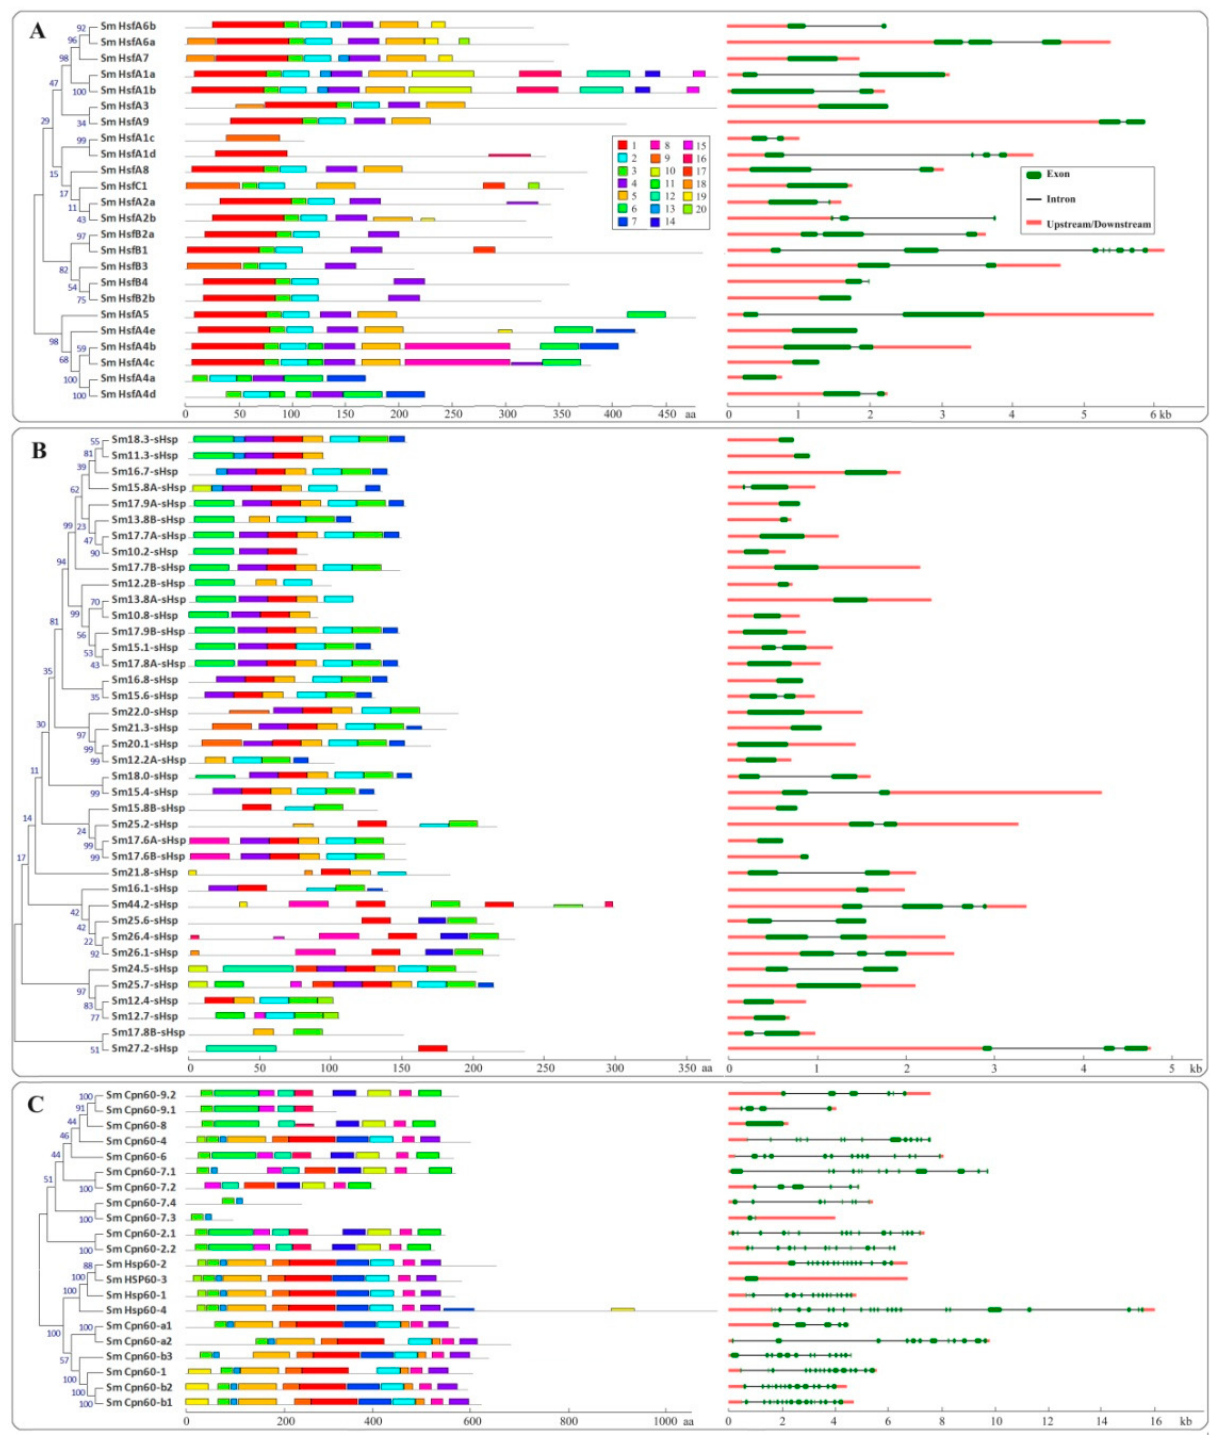
Figure 1. Phylogenetic relationships, gene structures and motif compositions of Hsf, sHsp and Hsp60 family members in eggplant. Multiple alignment of the Hsf ( A ), sHsp ( B ) and Hsp60 ( C ) proteins from eggplant (Sm) was performed with MEGA 5.0 using the neighbor-joining (NJ) method with 1000 bootstrap replicates (left panel). A schematic representation of conserved motifs (obtained using MEME) in the Hsf and sHsp proteins is displayed in the middle panel. Different motifs are represented by differently colored boxes. Details of the individual motifs are in Tables S8–S10. Exon/intron structures of the Hsf and sHsp genes are shown in the right panel. Green boxes represent exons and black lines represent introns.